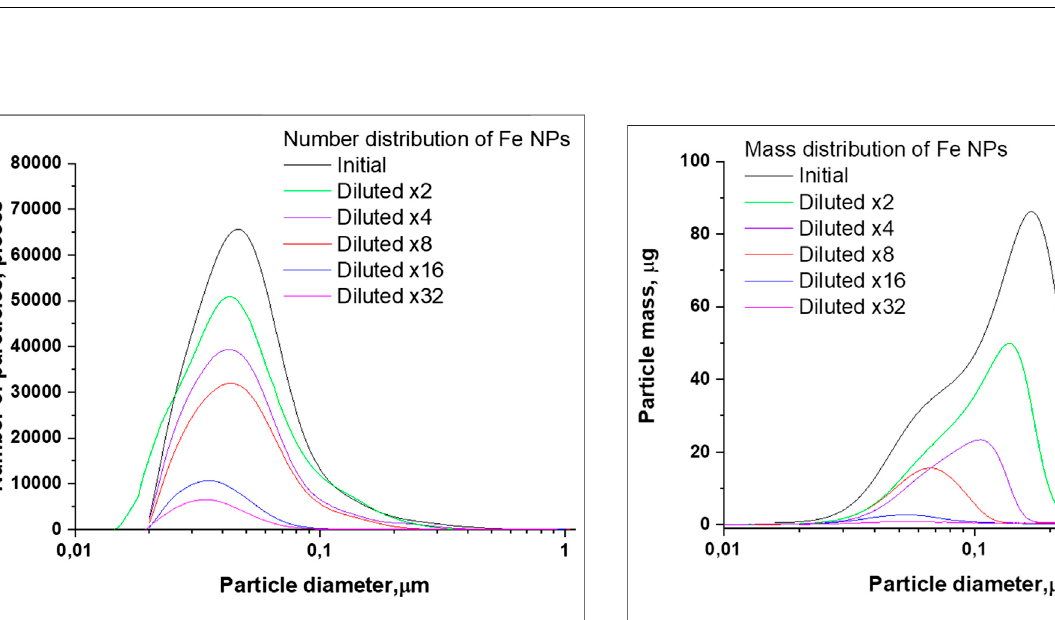
Frontiers in Physics |